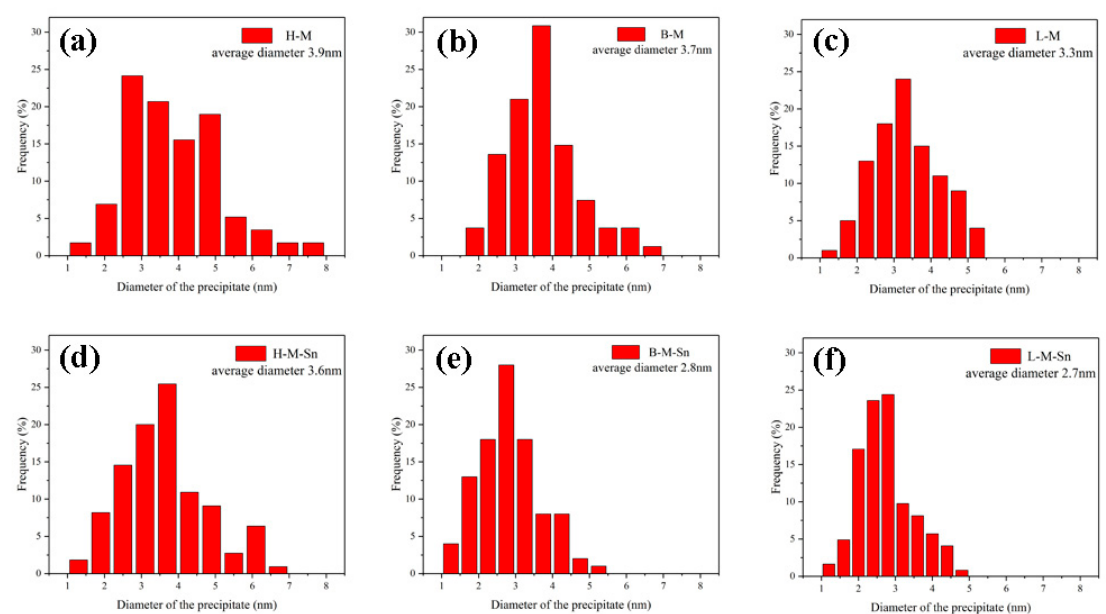
Figure 5. Average diameter and diameter distribution of the β″ precipitates in the peak aged alloys: